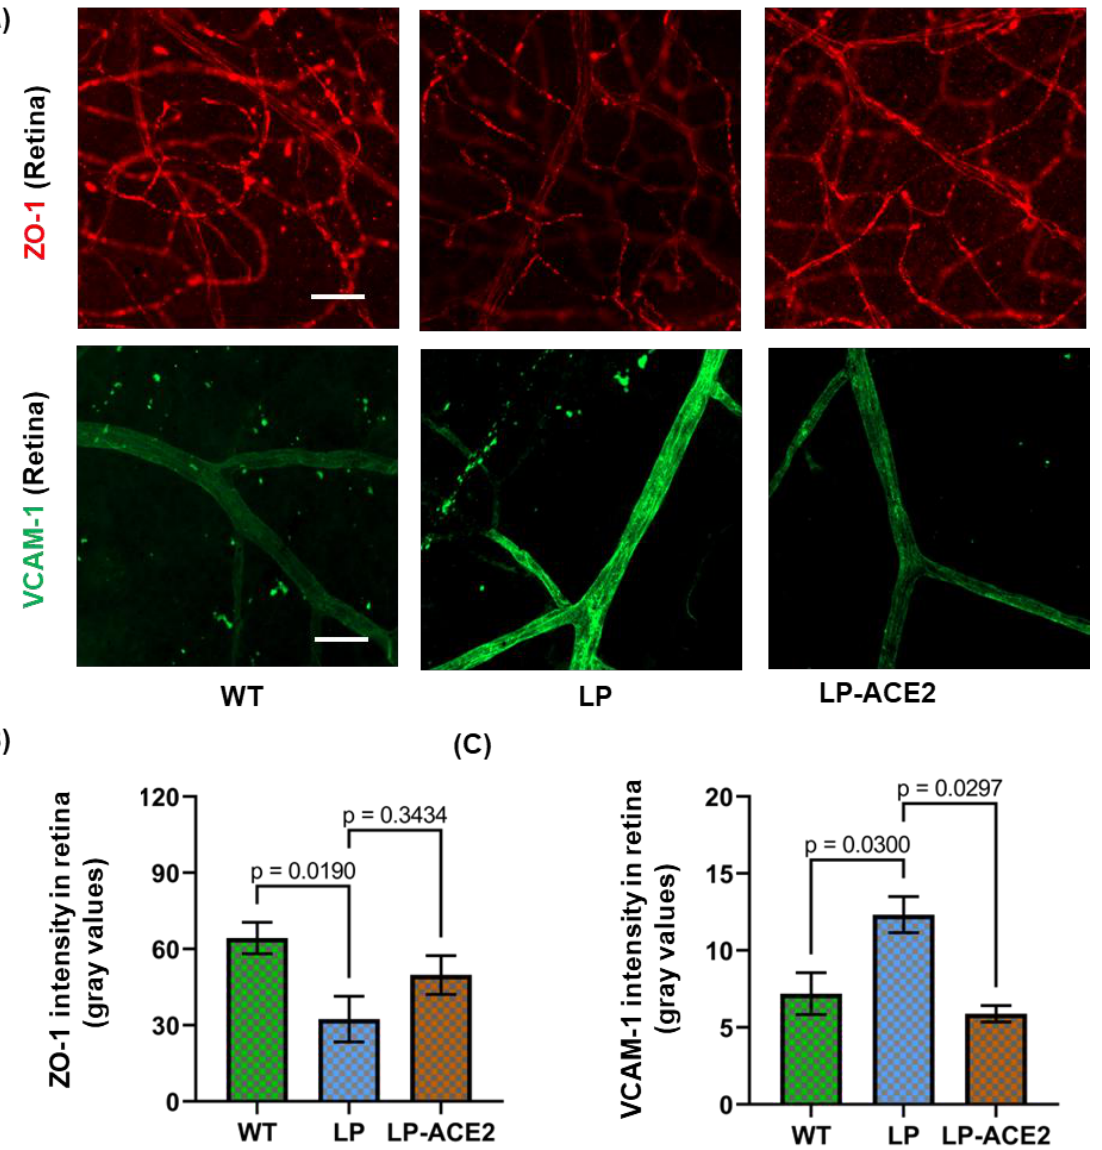
Figure 4. LP-ACE2 attenuates diabetes-induced disruption of blood-retinal barriers and retinal inflammation in Akita mice. Representative images of BRB marker ZO-1 (red) expression and retinal inflammation marker, VCAM-1 (green) expression in the retinal flatmounts ( A ). The expression levels of ZO-1 and VCAM-1 fluorescence are quantified and presented as mean intensity of gray values ± S.E.M of gray values ( B , C ). Data are analyzed by one-way ANOVA adjusted to account for multiple comparisons using Tukey’s test. Scale bar = 50 μm ( n = 6).